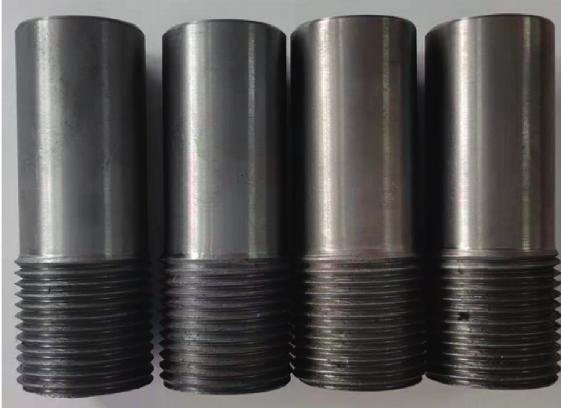
Figure 10: Photo of anchor socket.